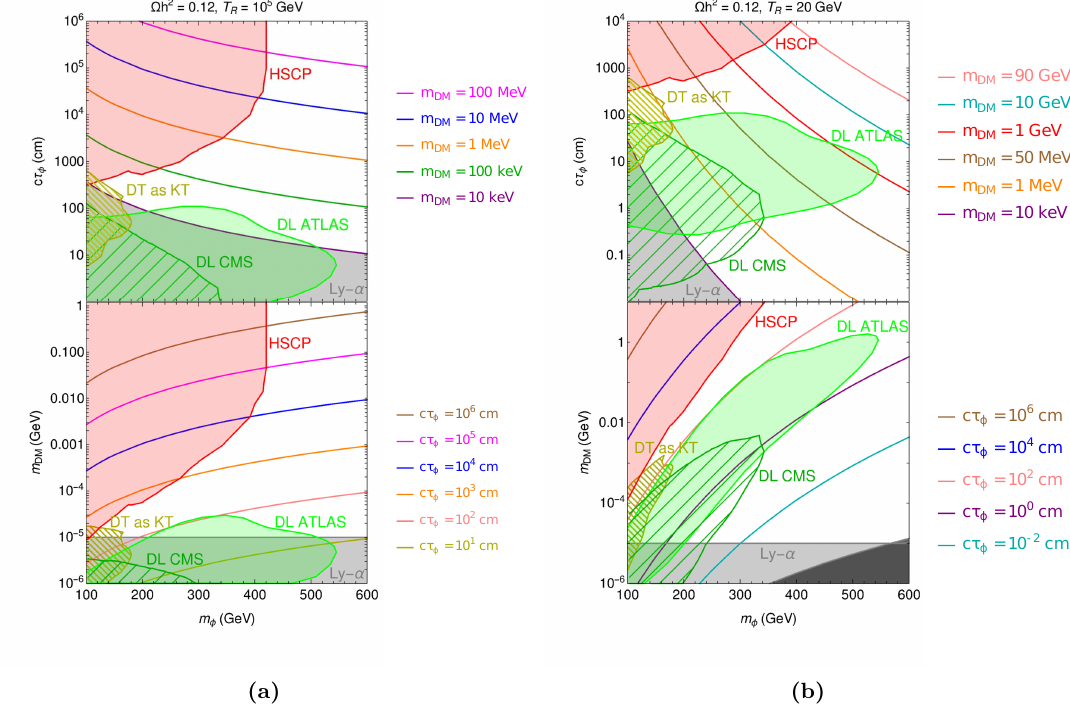
Figure 8. Leptophilic DM with T R = 10 5 GeV (left) and T R = 20 GeV (right). In the top panels, solid lines in the plane ( m ) reproduce the observed DM relic density for the associated φ , cτ φ m DM = m χ . Similarly, in the bottom panel we show relic density contours for the proper mediator decay length in the plane ( m ) . We identify regions excluded by HSCP searches from CMS φ , m DM and ATLAS (HSCP - red) and by displaced same-flavor lepton searches by ATLAS (DL ATLAS - uniform green). The possible reach from displaced same-flavor lepton by CMS is shown with a green loosely hatched region while our recasting of disappearing track searches in the case of a kinked track signature (DT as KT) is shown as a dark yellow densely hatched region. We denote with a light gray area regions excluded by the Lyman- α bound m & 10 keV, see text for details. Finally, DM in the dark gray region DM thermalize in the early universe and therefore cannot be produced via